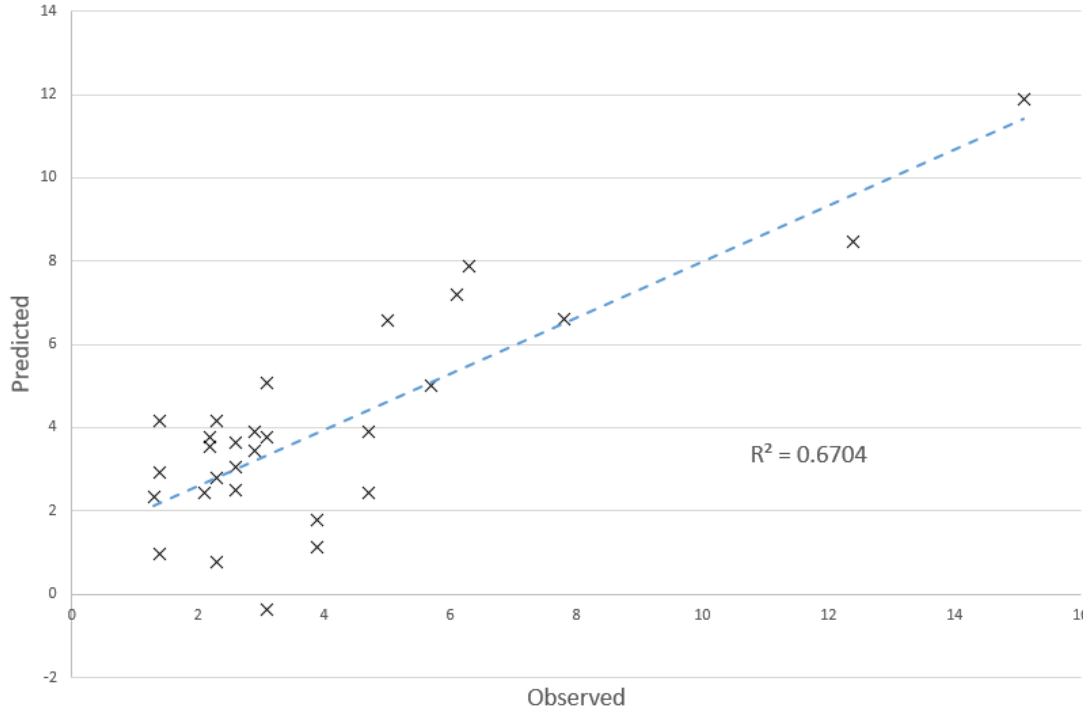
Figure 12. Scatterplot of predicted versus measured values for the SOM parameter.